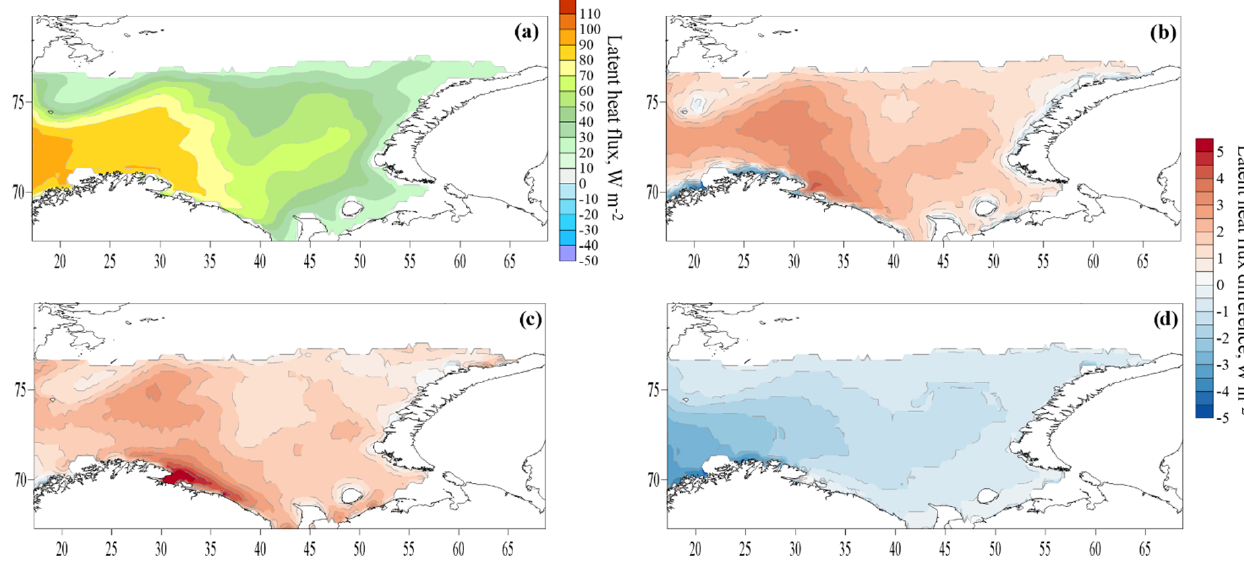
Figure 15. Mean latent heat flux in experiment C55 (a) and the flux difference in experiments T1–C55 (b) , O2–C55 (c) and D3–C55 (d) during